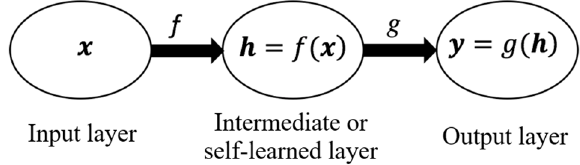
Figure 1. Three-layer AE structure.